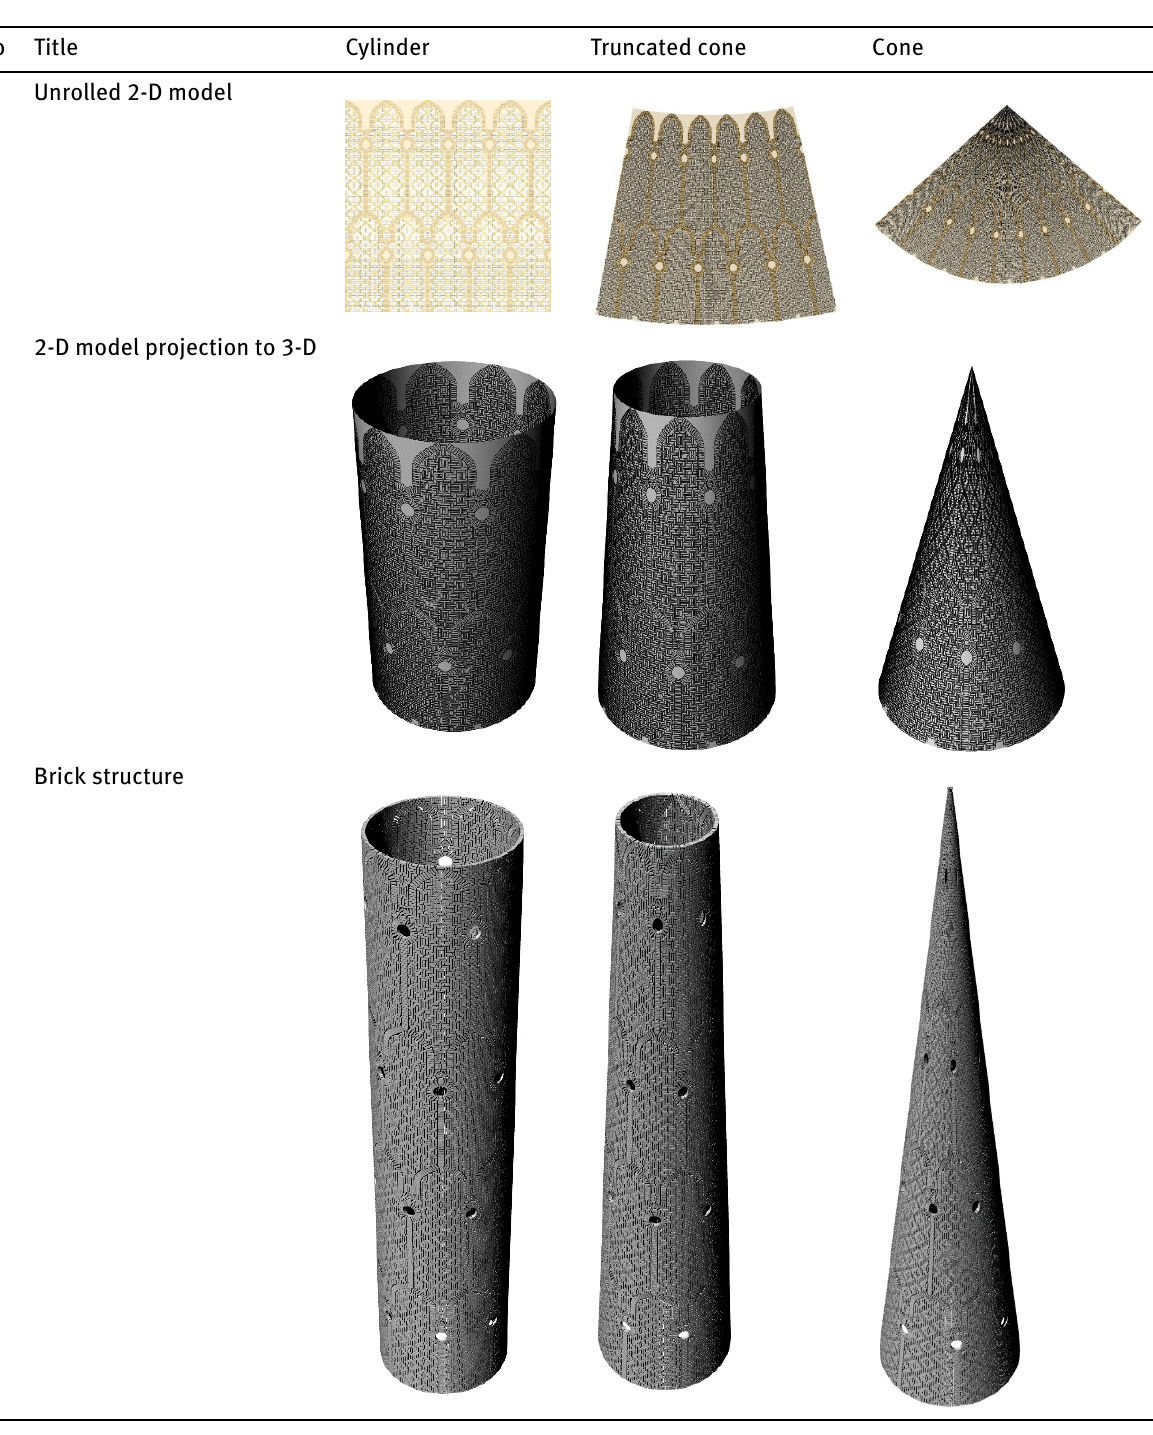
Table 5: The change process in girih pattern of the brickwork in the Sareban and Masjed-Ali minarets modeled on different 3-D shapes (cylinder, truncated cone, and